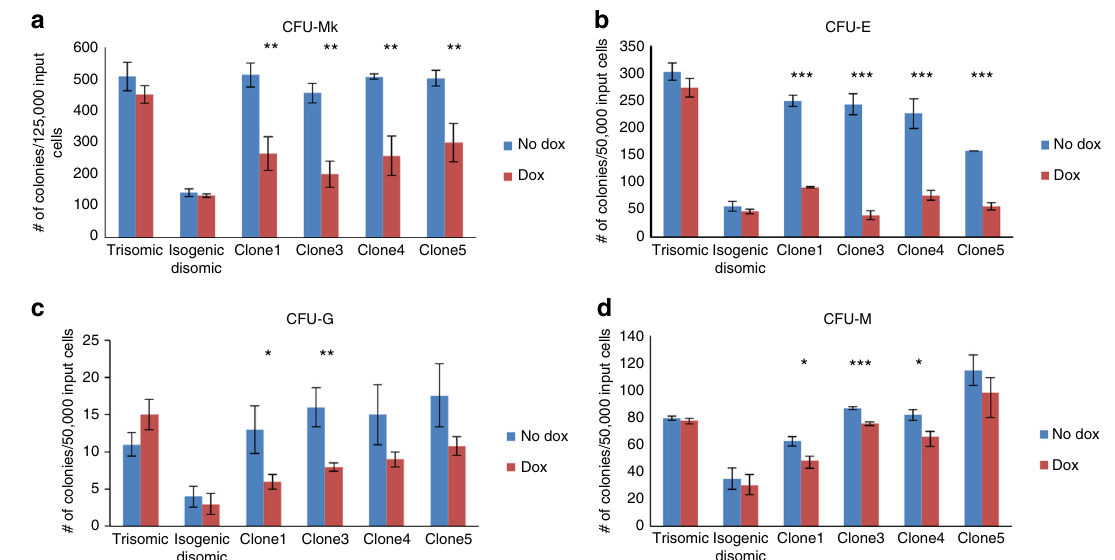
Fig. 3 Effect of XIST -induced trisomy silencing on colony-forming potential of DS iPSCs. Colony-forming potential of multiple isogenic transgenic DS iPS lines with and without XIST -induced chromosome 21 silencing for a megakaryocytes, b erythrocytes, c granulocytes, and d monocytes. Experiments were repeated at least three times. Error bars represent s.e.m. from three independent experiments and P values were calculated by Student t test; * P < 0.05, ** P < 0.01, *** P <